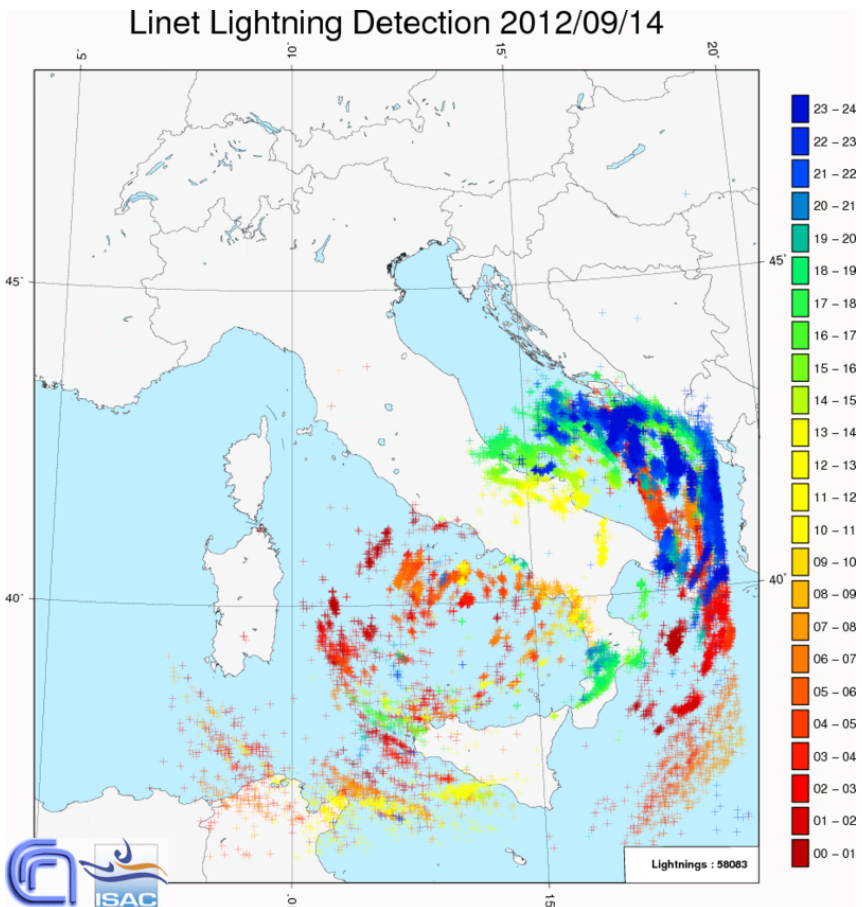
Figure 9. LINET lightning activity measured on 14 September 2012. The map shows the intra-cloud and cloud-to-ground strokes registered in 24h. Different colors are associated with different